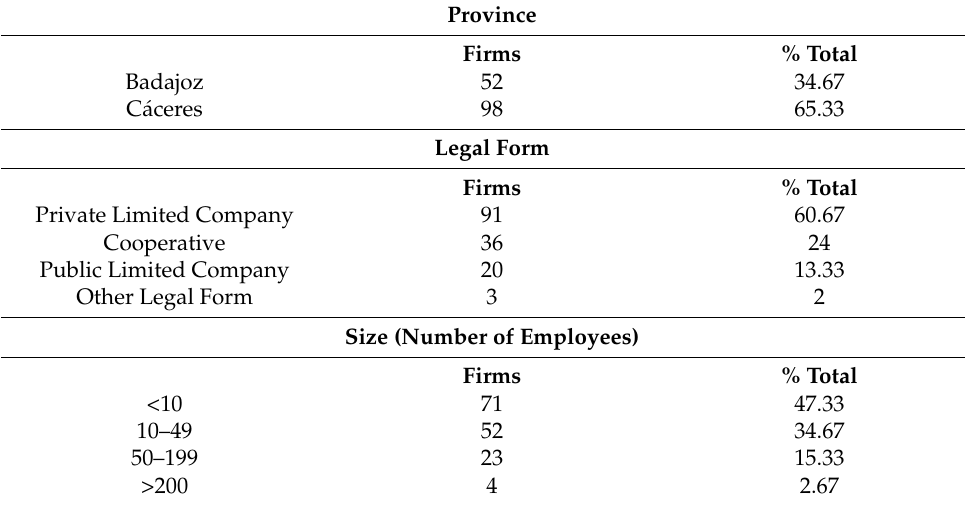
Table 1. Characteristics of the companies.